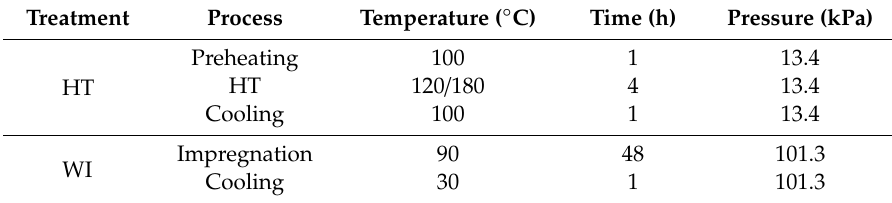
Table 1. Experimental design for heat treatment (HT) and wax impregnation (WI) processes. Treatment Process Temperature ( ◦